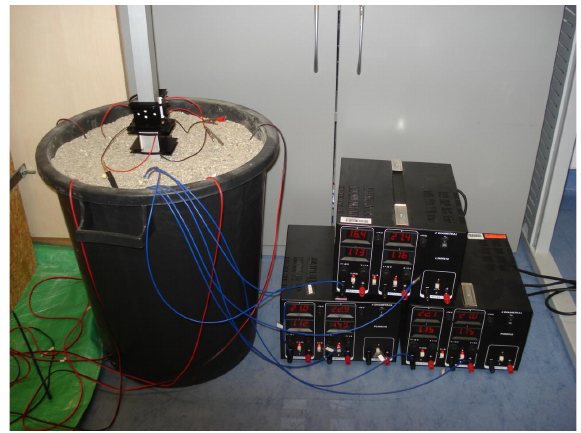
Figure 8. Photography of experimental setup for simulation of real conditions.